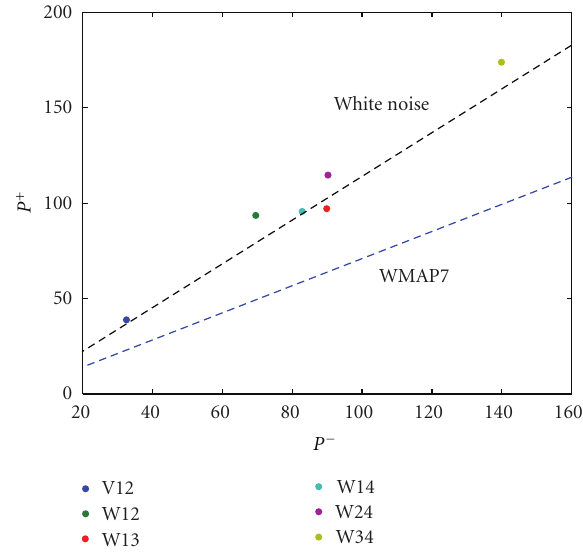
Figure 9: The parity asymmetry of the WMAP noise: the dots denote ( P + , P − ) of noise maps, and alphanumeric values in the leg- end denote the frequency band and the pair of D/A channels used. Two dashed lines are plotted with the slope corresponding to P + /P − of white noise and WMAP7 data,